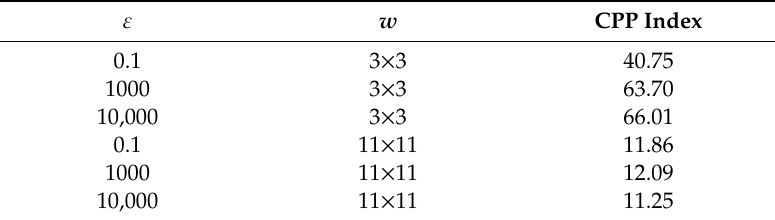
Table 4. Comparison of the CPP Indices with Different Parameter Combinations.